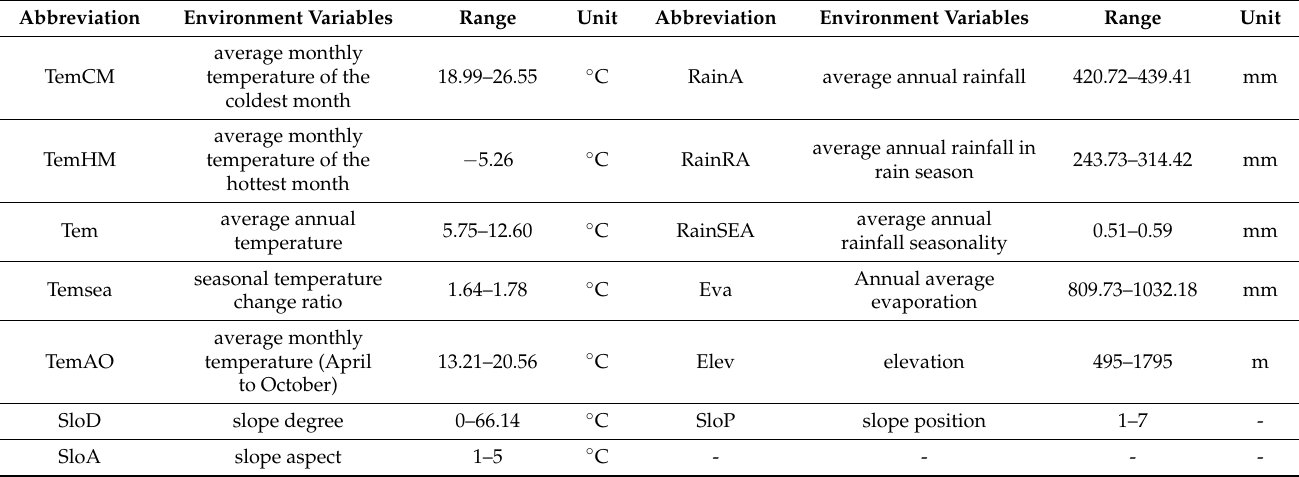
Table 1. Environmental variables that were used to build the native species distribution models using MaxEnt and description of these